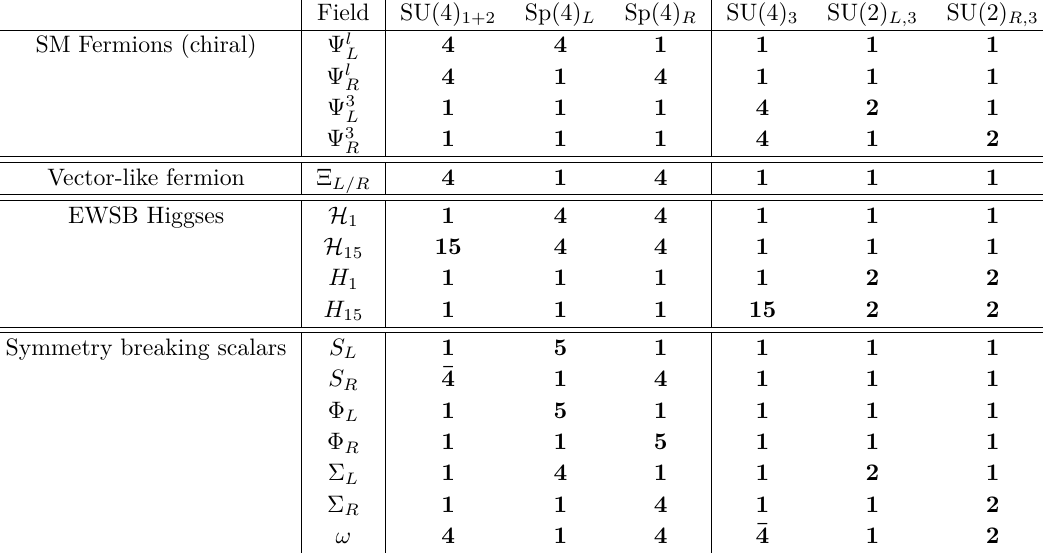
Table 1 . Field content of the model. In addition to the SM fermions, there are various scalar fields in which the electroweak symmetry breaking Higgs fields are embedded, as well as other symmetry breaking scalars that break the gauge symmetry down to the SM, plus a vector-like